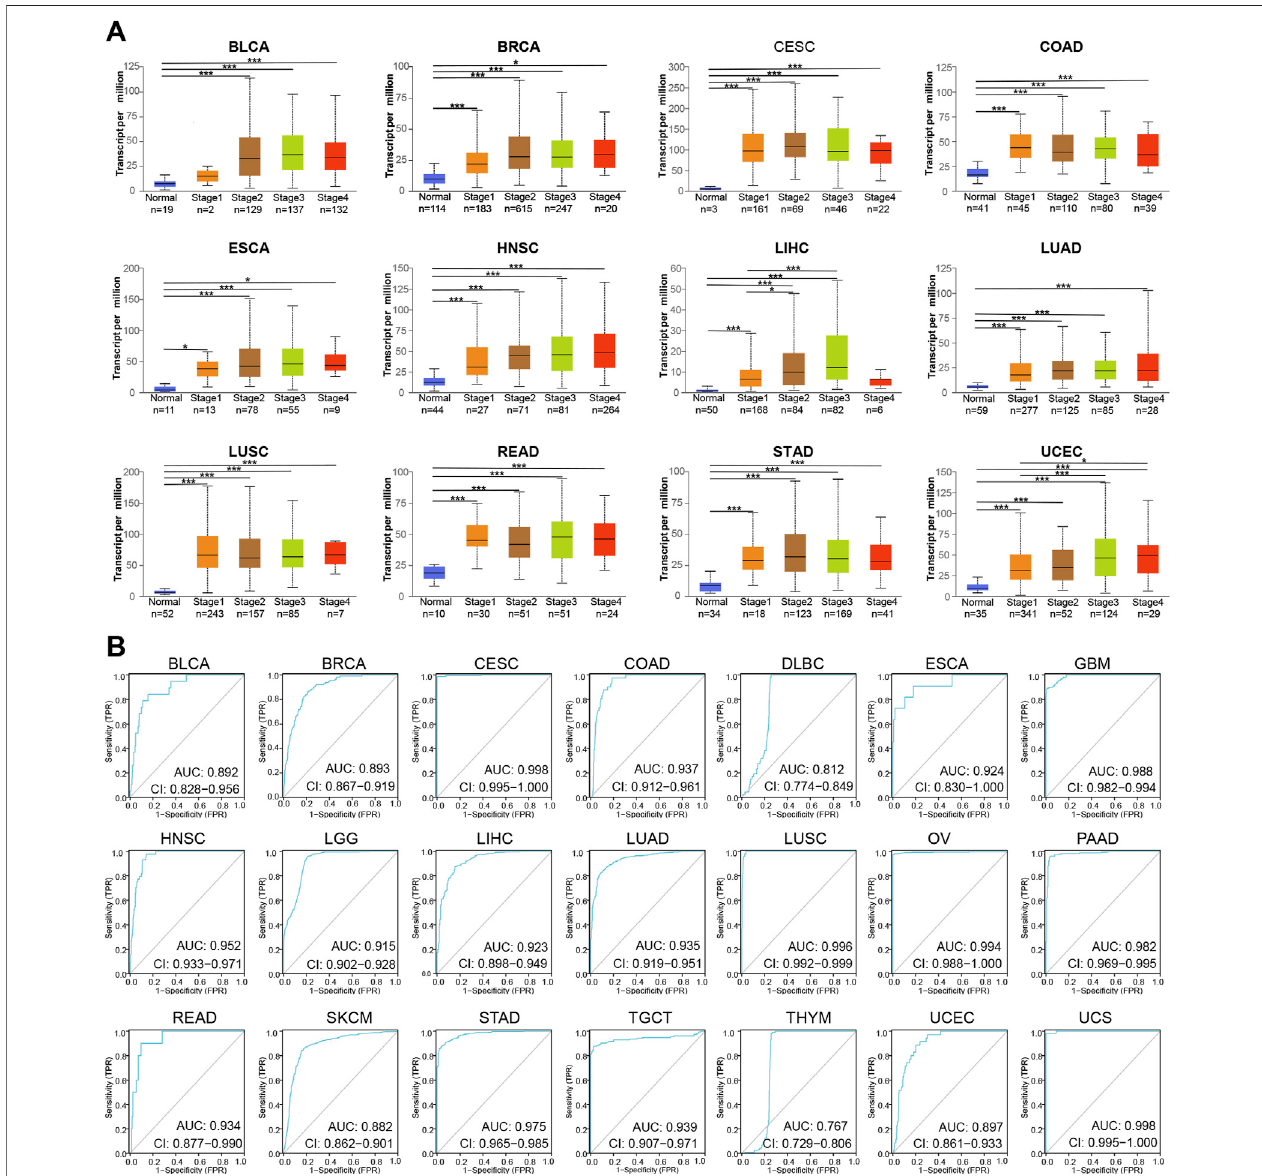
FIGURE8| Theprognostic value ofMCM2 invarious cancers. (A) Thecorrelationbetweentranscriptionlevels of MCM2 and cancer stage inpatients. (B) AUCsof MCM2 in predicting the prognosis of patients with various types of cancer.